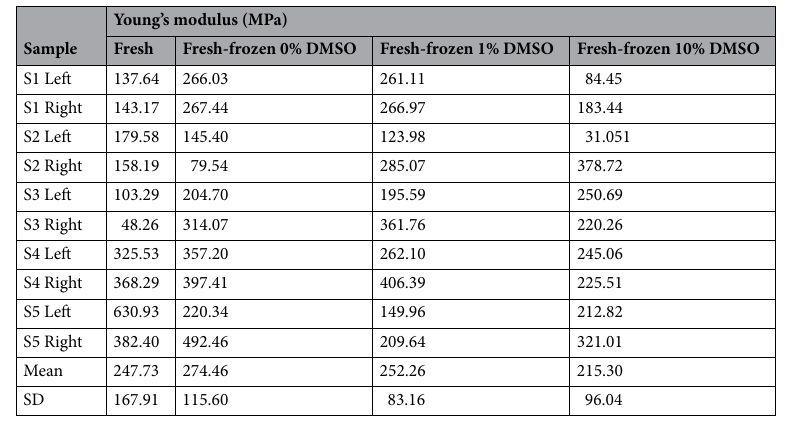
Table 1. Determined Young’s moduli of the examined iliotibial tract specimens (5 donors, left and right side).